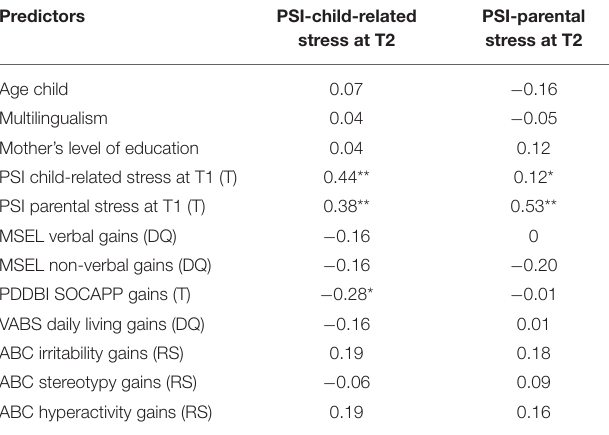
variables listed in Table 3 was included in further regression analyses. Two independent multiple hierarchical regression